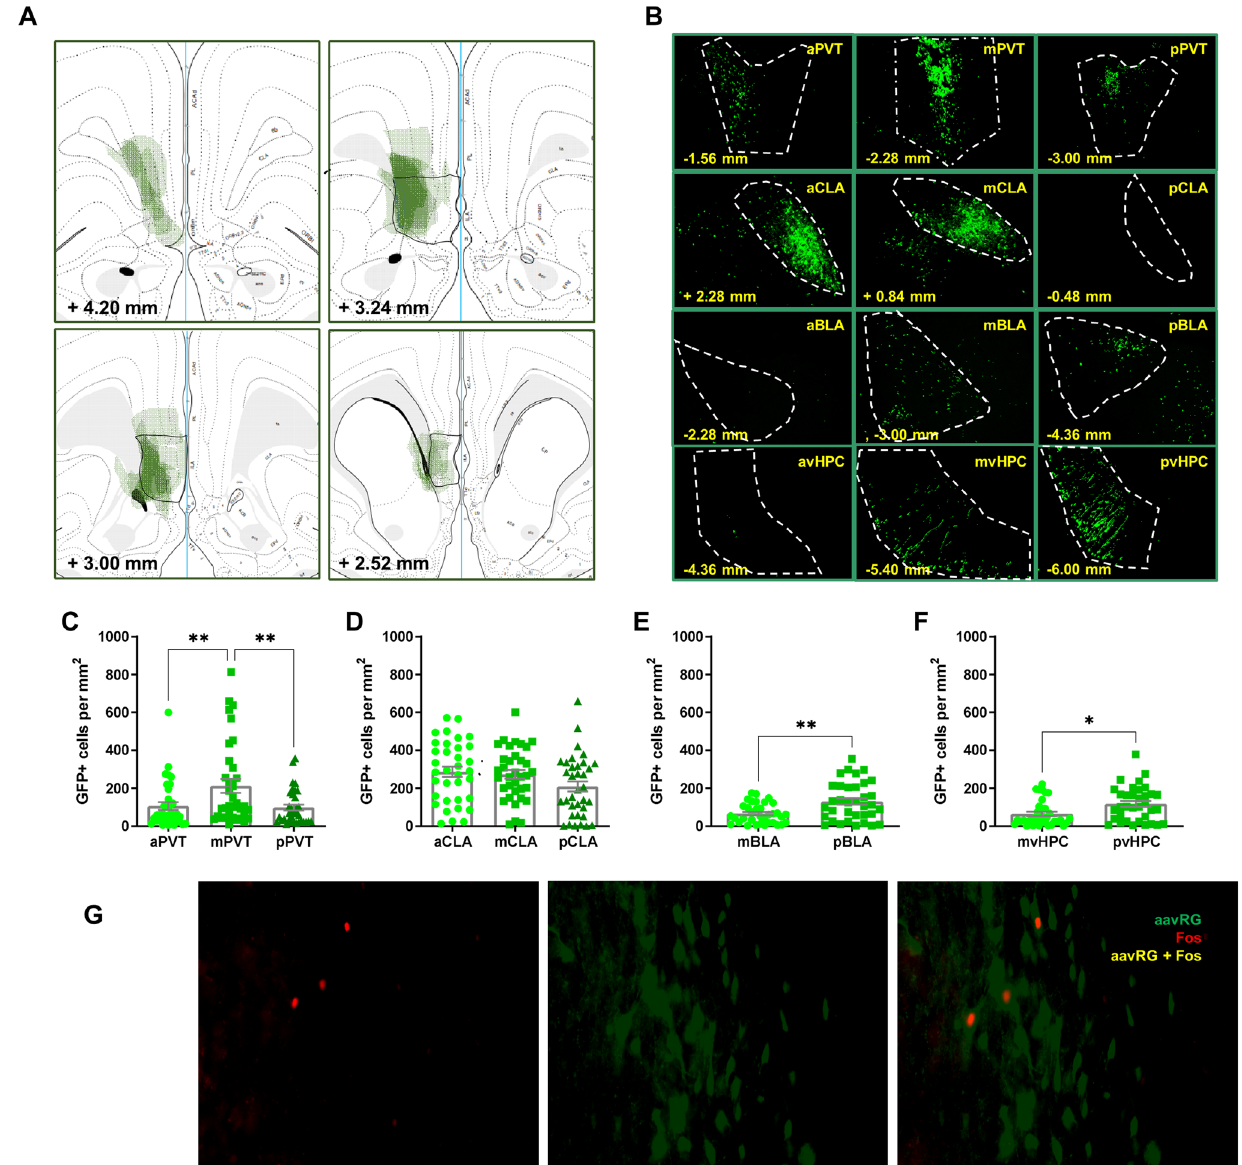
Figure 3. Quantification of IL-afferents throughout the brain areas of interest. ( A ) Schematic representation of the aavRG-CAG-GFP spread throughout the IL of included rats. ( B ) Representative images of retrograde labeling in different anteroposterior locations of brain areas of interest. Quantification of retrograde label along the anteroposterior axis of the ( C ) paraventricular thalamus, ( D ) claustrum, ( E ) basolateral amygdala, and ( F ) ventral hippocampus. ( G ) Representative images demonstrating aavRG retrograde labeling, Fos labeling, and double-labeling of aavRG and Fos in the aPVT. Error bars represent standard error of the mean. * p < 0.05, ** p < 0.01. Scale bar 100 µm. The open access brain maps in Panel A are reproduced from Swanson (2004) Brain maps: structure of the rat brain, 3rd edition; under the terms of a Creative Commons Attribution-Non Commercial 4.0 International License (https:// creat iveco mmons. org/ licen ses/ by- nc/4. 0/) and are available for download at https:// larry wswan son.